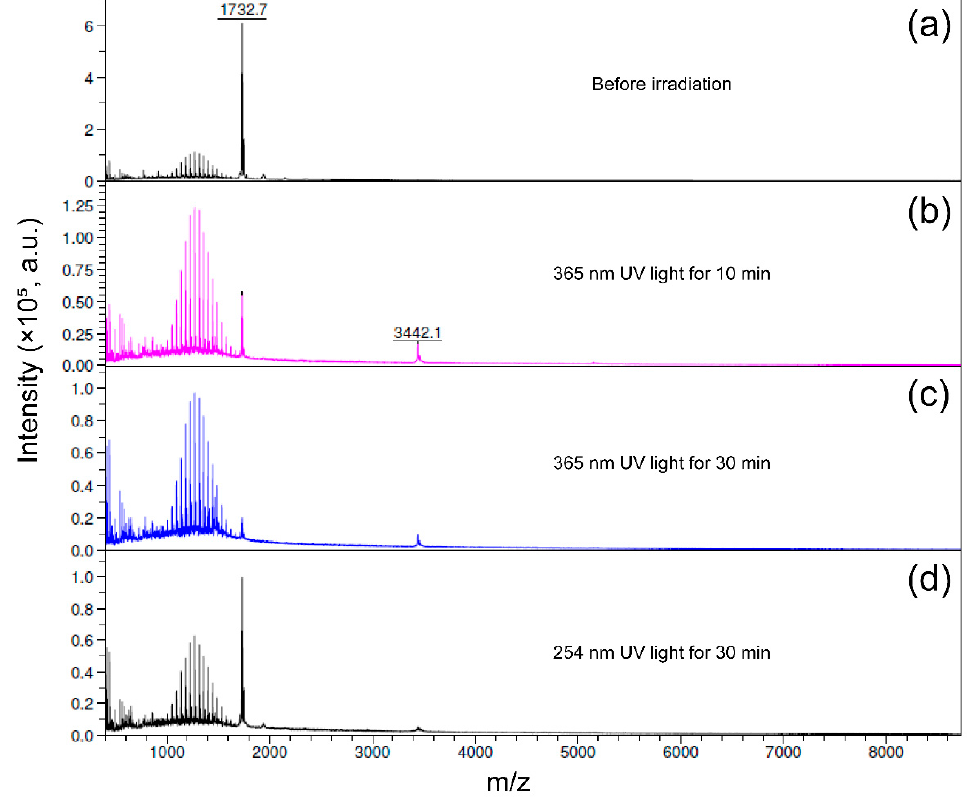
Figure 4. MALDI TOF MS results of the mixed solution containing 10% Cou-crosslinker before irradiation ( a ) and after irradiation with UV light with a wavelength of 365 nm for 10 min ( b ) and 30 min ( c ) and irradiation with UV light with a wavelength of 254 nm for 30 min ( d ).